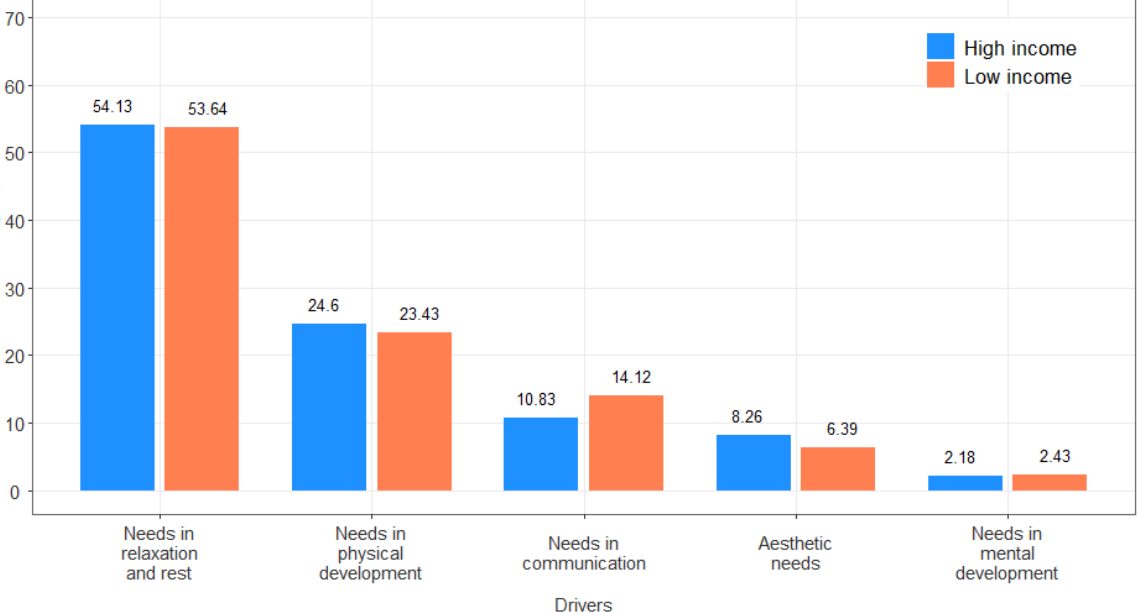
Table 7. The results of the Chi-square test for between-group (income) comparisons across forests.